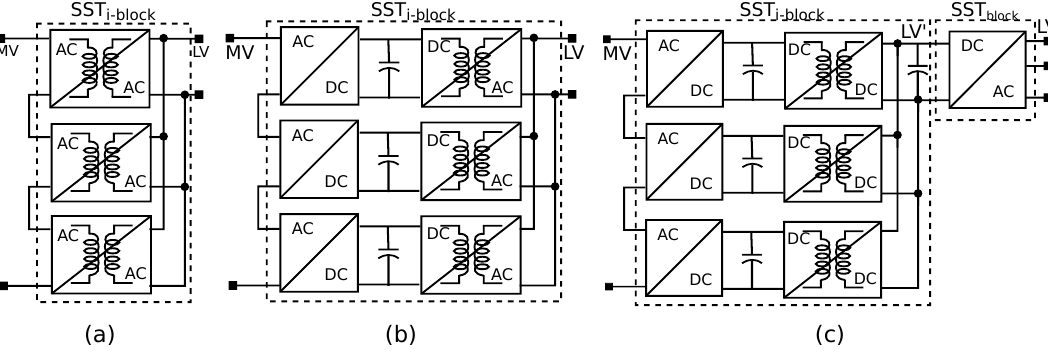
Figure 20. Modularity in voltage interconnection: ( a ) single stage cells fully modular [91], ( b ) two stage cells fully modular [58], and ( c ) hybrid-cell modular SST